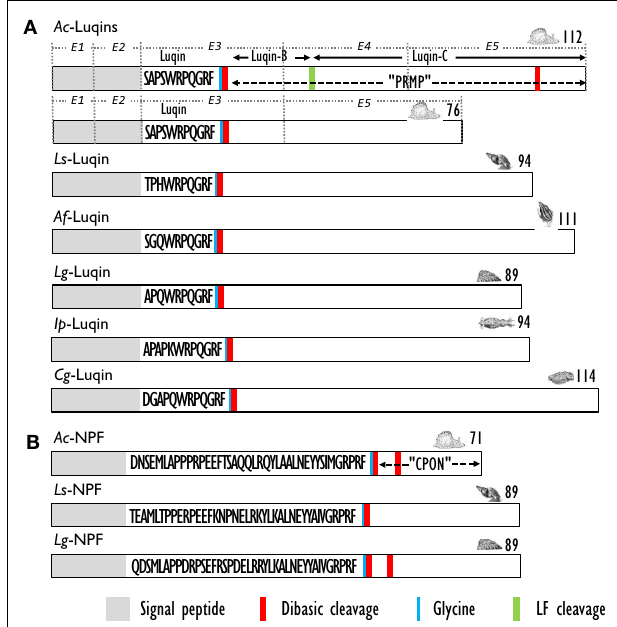
FIGURE 4 | (A) Comparison of the linear schematic organization of Luqin precursors in mollusks: Ac -Luqin identified in Aplysia californica (101) , Ls- Luqin (LyCEP: Lymnaea CardioExcitatory Peptide) in Lymnaea stagnalis (104) , Af- Luqin (ACEP: Achatina CardioExcitatory Peptide) in Achatina fulica (108), Lg- Luqin in Lottia gigantea , Ip -Luqin in Idiosepius paradoxus, and Cg -Luqin in Crassostrea gigas (27). (B) Comparison of the linear schematic organization of NPF precursors in gastropods: Ac -NPF in A. californica (109), Ls -NPF in L. stagnalis (93), and Lg -NPF in Lottia gigantea (27). Signal peptides, proteolytic processing sites, and C-terminal glycines for amidation are indicated by distinct labels. CPON, carboxy-terminal peptide of NPF; PRMP, proline-rich mature peptide. For Ac -Luqin precursors, the respective encoding exons are indicated as E1, E2, E3, E4, and E5.